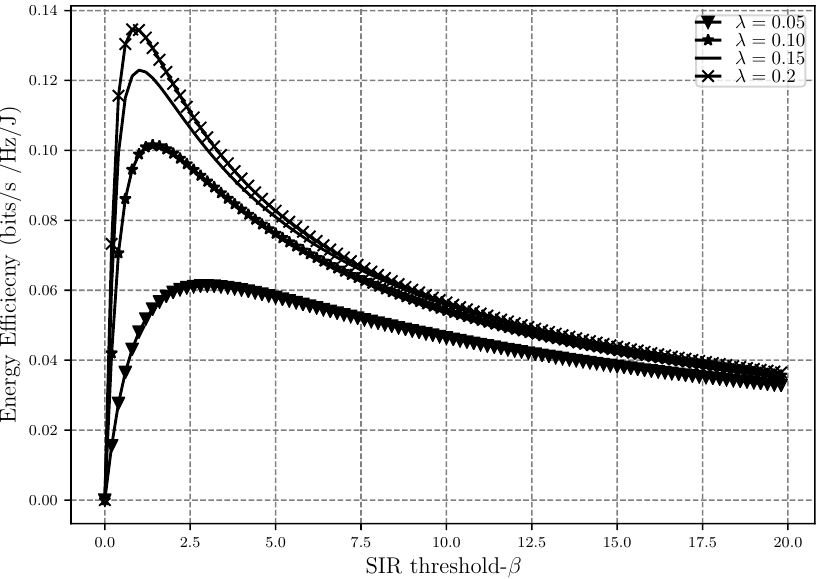
Figure 9. Energy efficiency EE versus the SIR threshold β with different network densities λ and α = 4, r 0 = 1, m = 5 and (cid:101) =